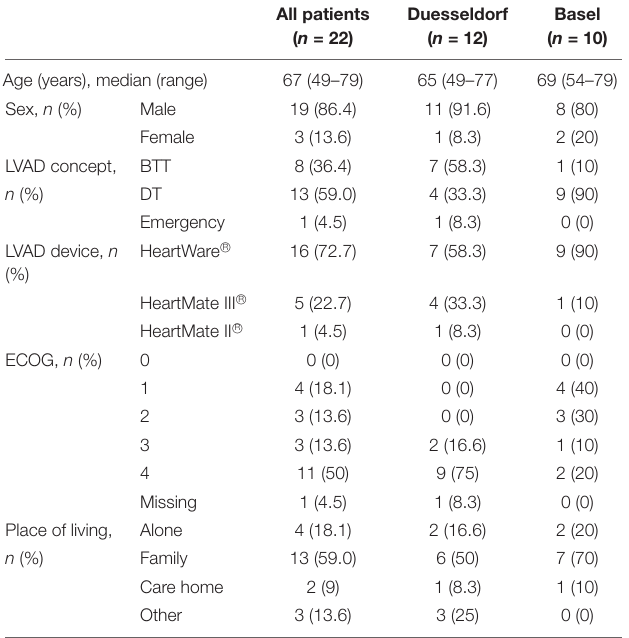
FIGURE 2 | Time in days between left ventricular assist device (LVAD) implantation and first specialist Palliative Care (sPC)-contact (LVAD-sPC) and first sPC-contact until death (sPC-death) in Basel (orange, n = 10) and Duesseldorf (blue, n = 12). Horizontal lines represent mean duration in days.